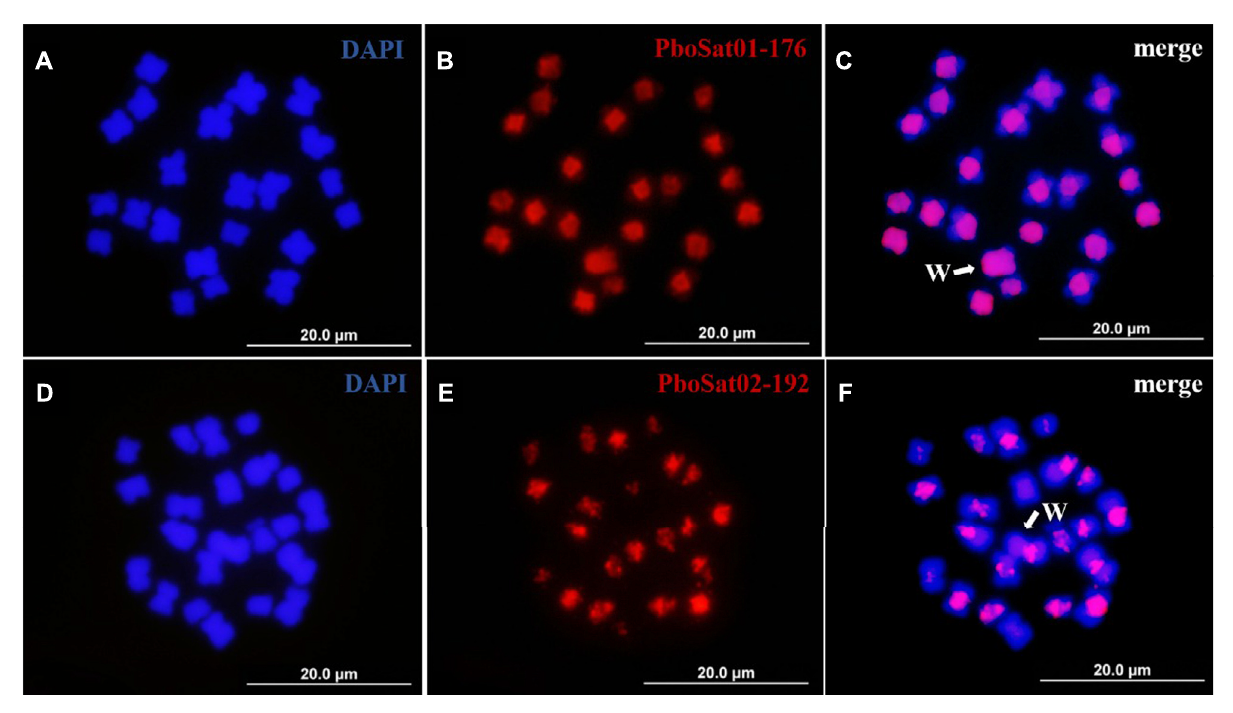
FIGURE 3 FISH mapping of two more abundant satDNAs (red) and in mitotic metaphase of Proceratophrys boiei female individual. (A,D) chromosomes counterstained with DAPI; (B) PboSat01-176; (E) PboSat02-192; (C,F) merge. Note that both satDNAs showed a high clustering in centromeric and pericentromeric region of chromosomes. Sex chromosome W is highlighting in C and F